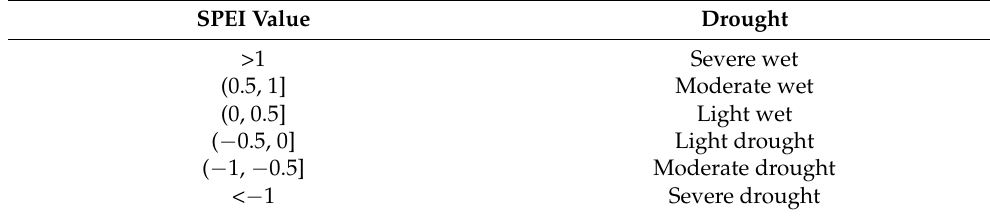
Table 1. Drought classification based on